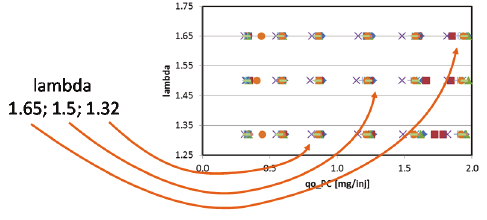
Fig. 7. Predefined constant values of excess air coefficient By averaging of the qo_PC values, the representative points qo_PC were selected. These were: 0.35; 0.6; 0.9; 1.2; 1.6; 1.9 mg/inj (Fig. 8).